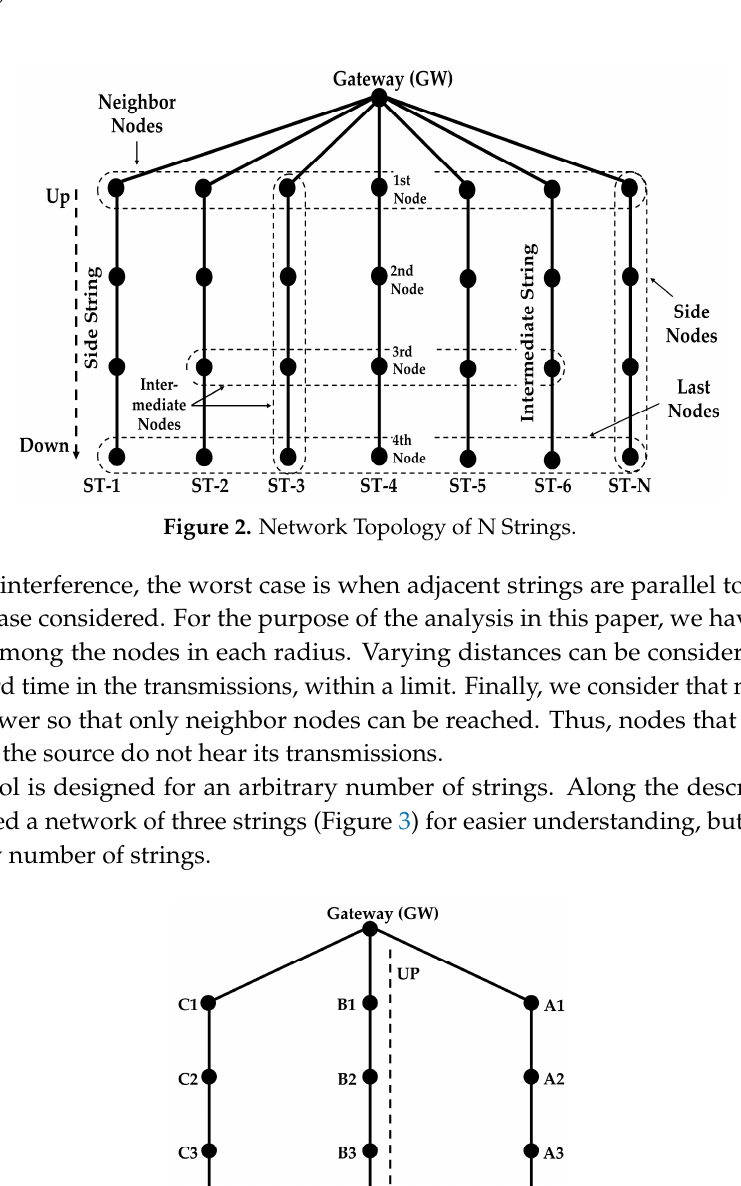
Figure 3. Example of network with three Strings.